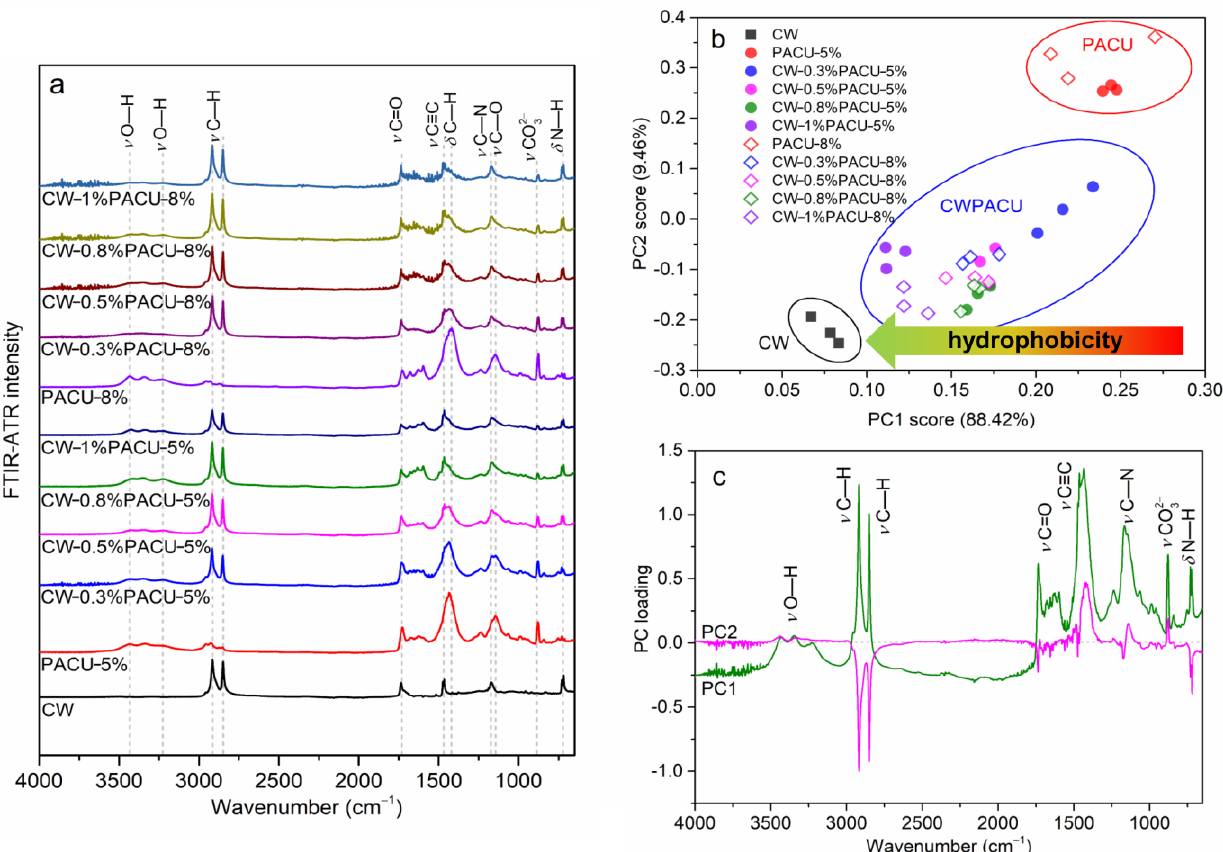
Figure 3. FTIR-ATR spectral characteristic of the PACU and CWPACU. ( a ) Comparison between FTIR-ATR spectra of PACU and CWPACU. ( b ) Principal component scores of FTIR-ATR spectra for the PACU and CWPACU. ( c ) Principal component loading of FTIR-ATR spectra for different PACU and CWPACU.